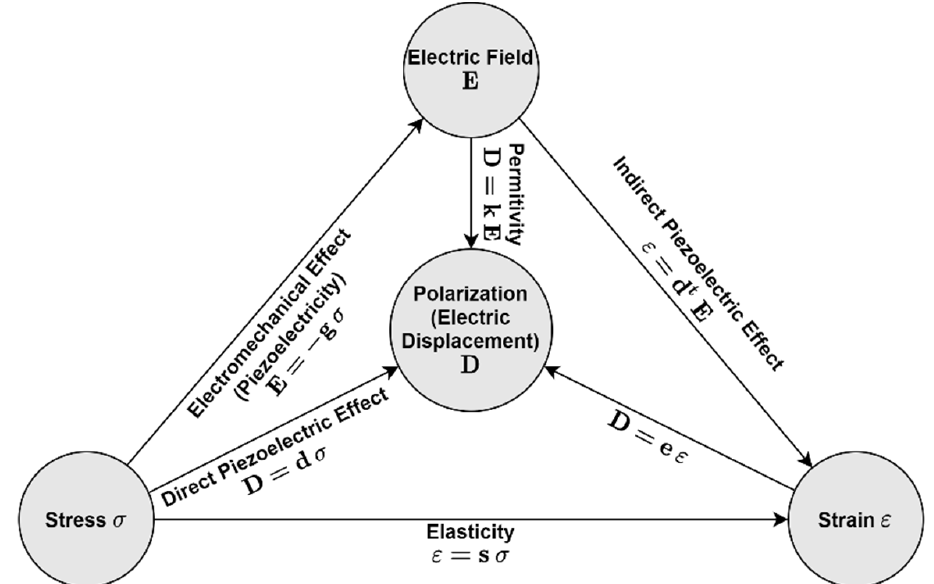
Figure 1. Effect of Piezoelectric material [15]. Reprinted under the Creative Commons (CC) License (CC BY 4.0).